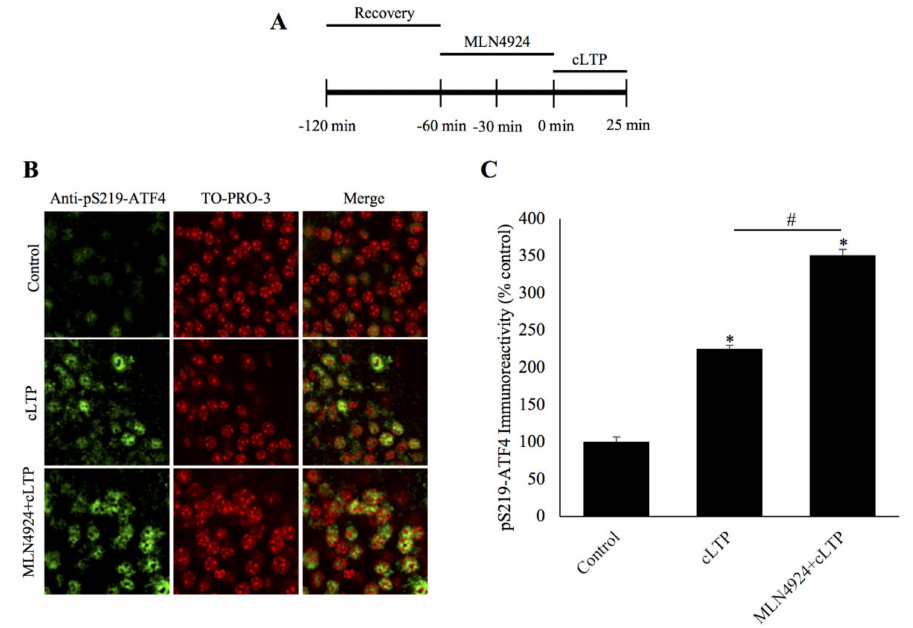
Figure 3. Inhibition of neddylation prevents degradation of phosphorylated ATF4 during chemically induced long-term potentiation. ( A ) Schematic outline of the experiment: during the second hour of recovery period, the slices were incubated with the neddylation inhibitor, MLN4924. The beginning of cLTP induction is designated as 0 min. ( B ) Confocal microscopy images of pSer219-ATF4 and the nuclear counterstain TO-PRO-3 25 min after cLTP induction, time-matched controls, and slices pretreated with the small molecule neddylation inhibitor MLN4924 before cLTP induction. pSer219-ATF4 levels are markedly increased relative to time-matched controls and the inhibition of neddylation significantly increases pS219-ATF4 levels after cLTP. ( C ) Quantification of pSer219-ATF4 immunoreactivity shows that the neddylation inhibitor MLN4924 causes accumulation of phosphorylated ATF4 after cLTP induction. * p < 0.01 between cLTP and time-matched controls, # p < 0.01 between treatment groups, n = 6, one-way ANOVA, and Tukey post hoc